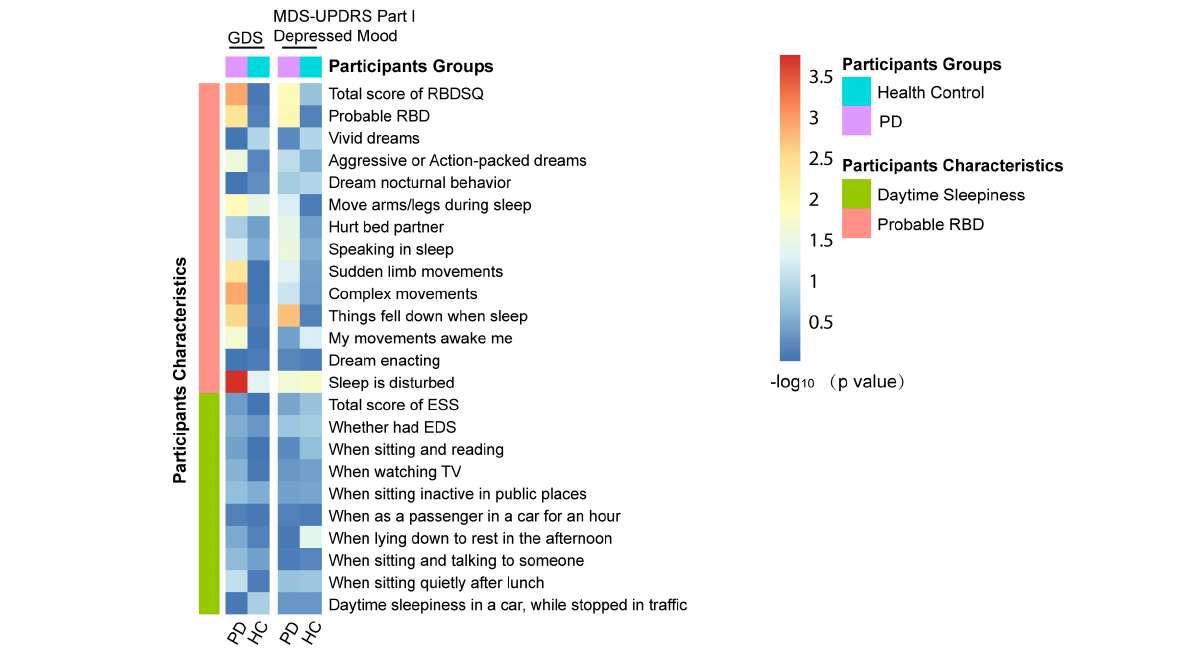
FIGURE 2 | Associations of sleep disorders with depression in cross-sectional